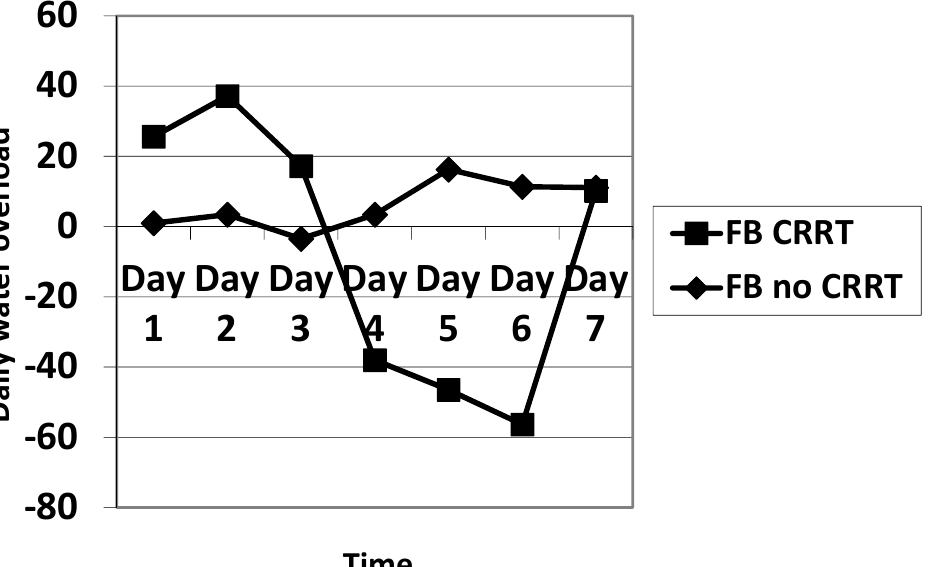
Figure 3. Comparison of the evolution of the fluid balance during the 7 days of ECMO between CRRT and no CRRT. FB: fluid balance.